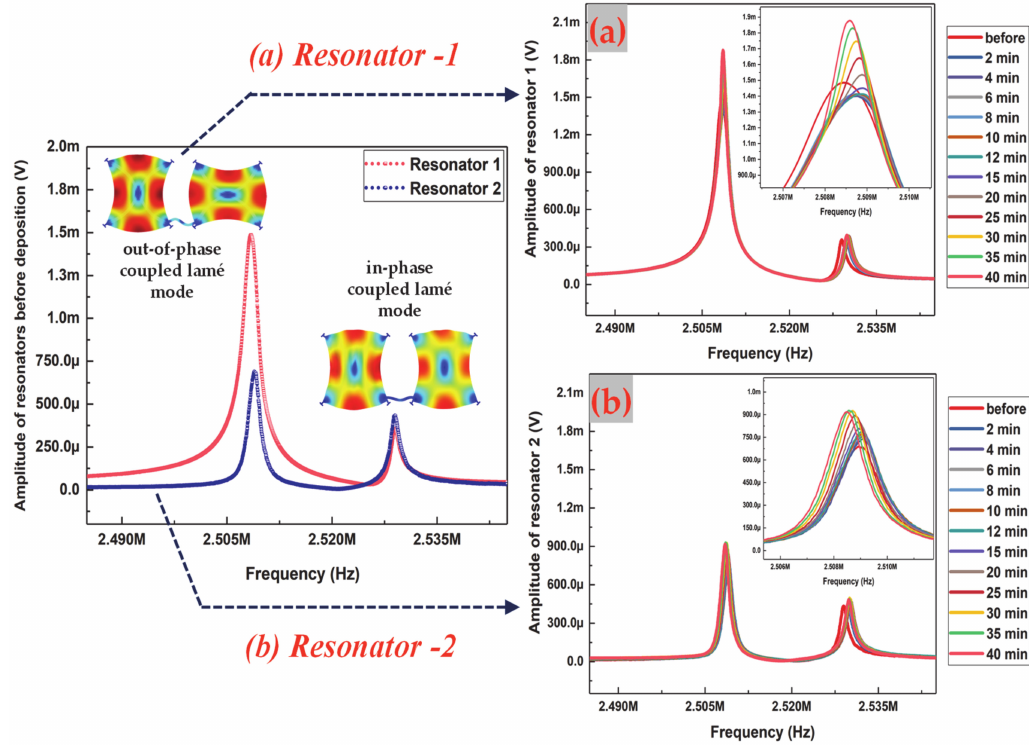
Figure 7. Frequency response of the coupled MEMS resonators monitored using lock-in amplifier before soot particle impaction; ( a ) Frequency response of resonator 1 and ( b ) Frequency response of resonator 2, monitored using lock-in amplifier for 40 min of soot particle impaction at di ff erent time intervals on one of the coupled